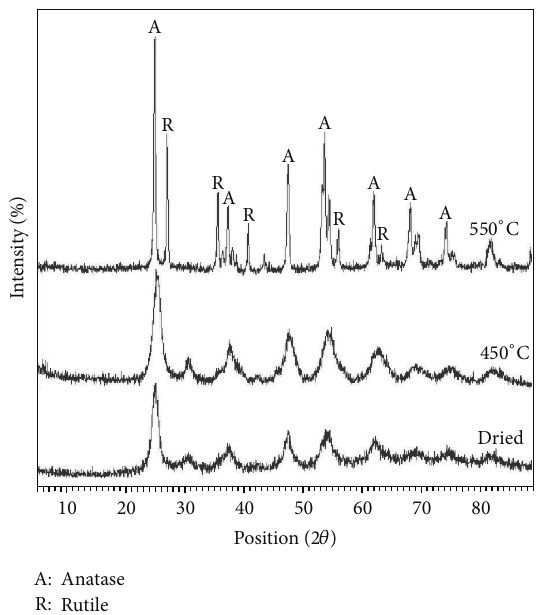
Figure 6: XRD patterns of the dried and calcined colloidal titania